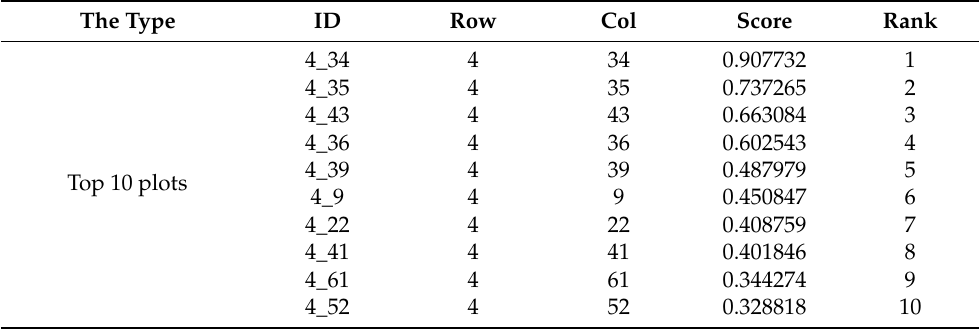
Table 4. Top 10 plots and last 10 plots of information based on TOPSIS for maize seedling emergence at Zhangye Station in